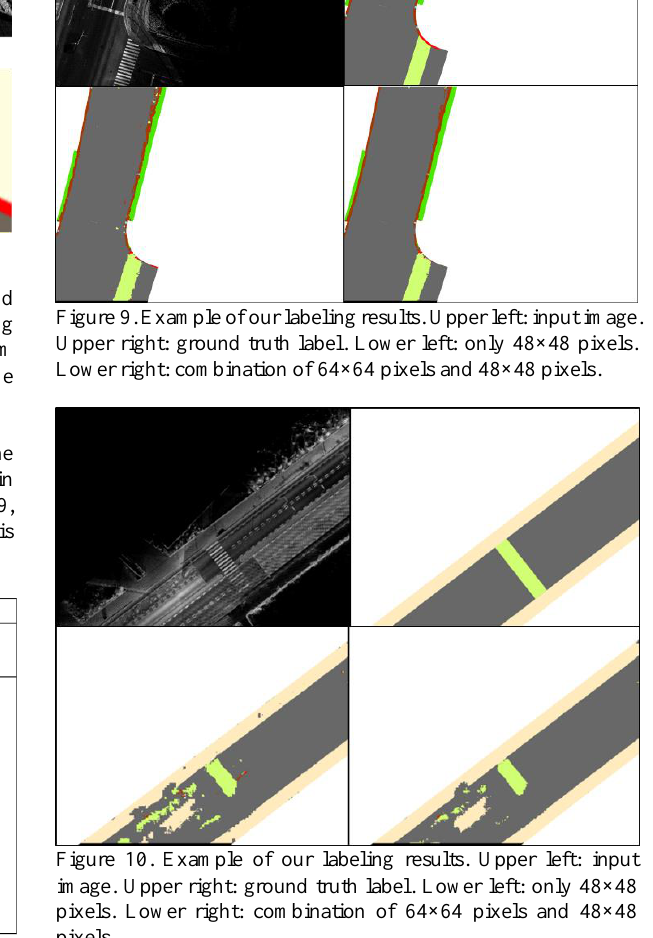
Table 2. Accuracy of our method using different region sizes. Left: only 48 × 48 pixels. Middle: combination of 64 × 64 pixels and 48 × 48 pixels. Right: combination of all sizes.